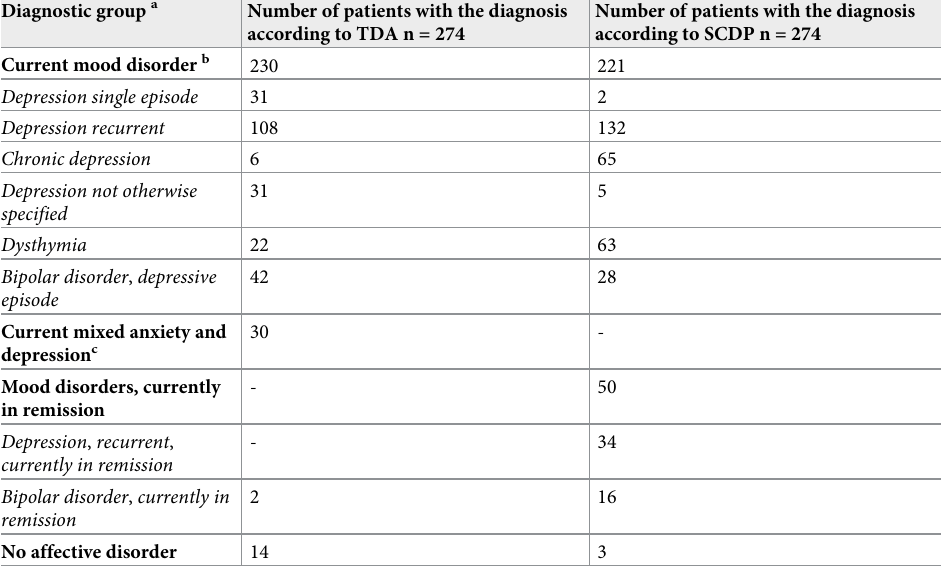
No affective disorder 3 a Patients could be assigned more than one diagnosis. b For bipolar disorder, only a depressive episode is included. c Mixed anxiety and depression is not considered a mood disorder in this study.